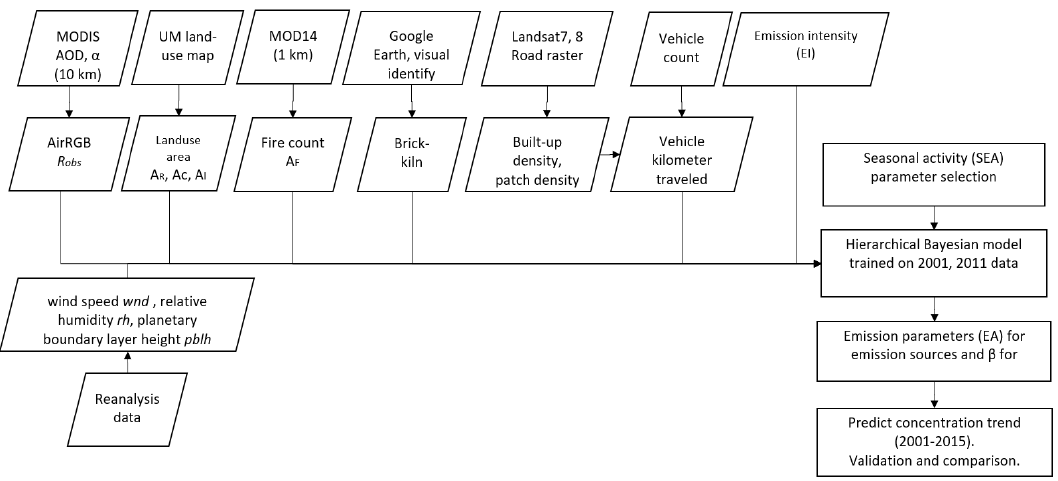
Figure 1. Overall flowchart to predict concentration with respect urban